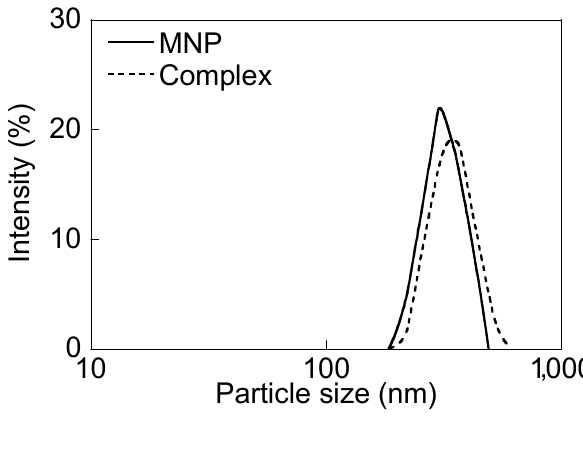
Figure 10. The size distribution of PEI-coated Fe 3 O 4 nanoparticles and the complexes in phosphate-buffered saline (PBS). The size of PEI-coated Fe 3 O 4 nanoparticles and the complexes were 318 ± 57 nm and 349 ± 70 nm,